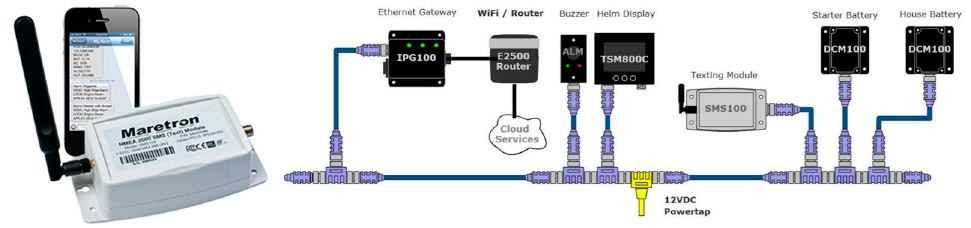
Figure 10. SMS100 short message service (Text) module [71].